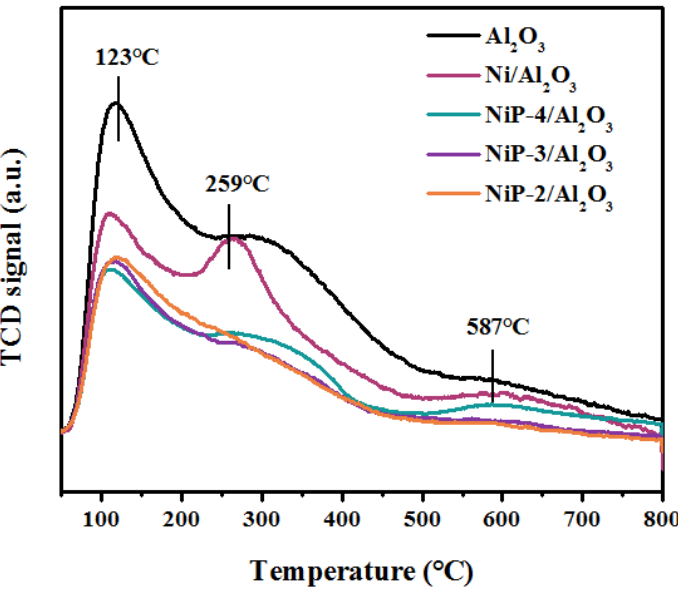
Figure 5. NH 3 -TPD profiles of reduced Ni/Al 2 O 3 and NiP-x/Al 2 O 3 catalysts.